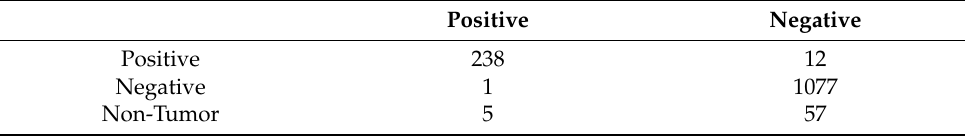
Table 4. PN classification